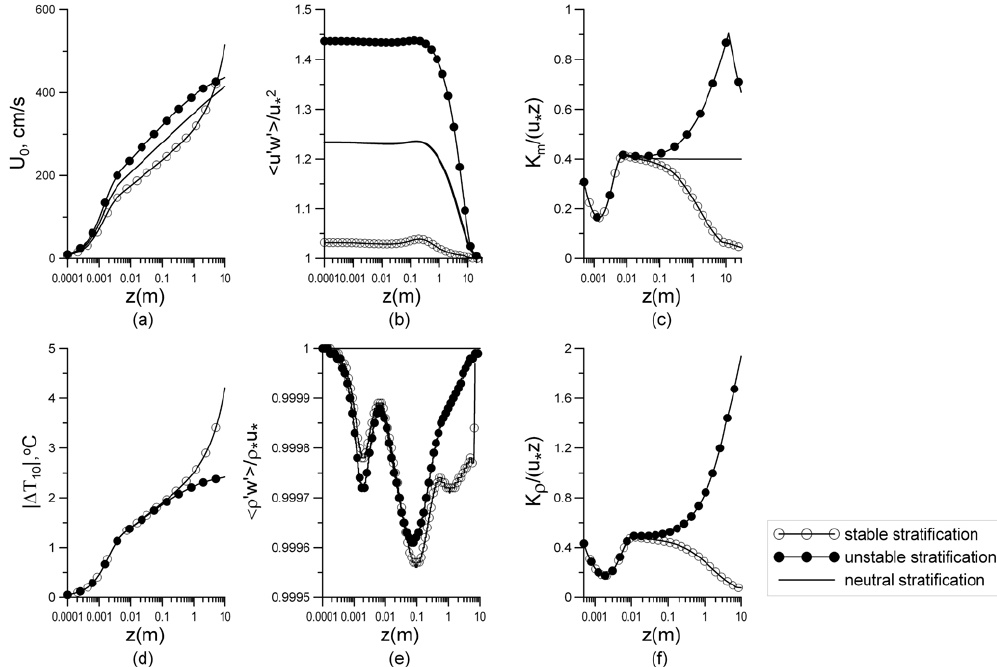
Fig. 3. The same as in Fig. 1 for kL = 0 .